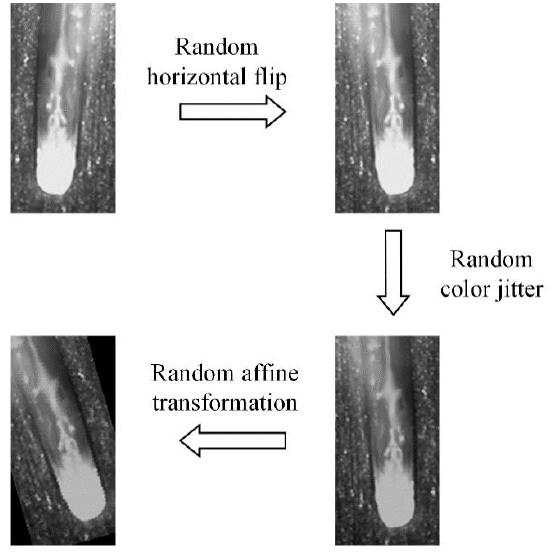
Figure 7. Data augmentation process.